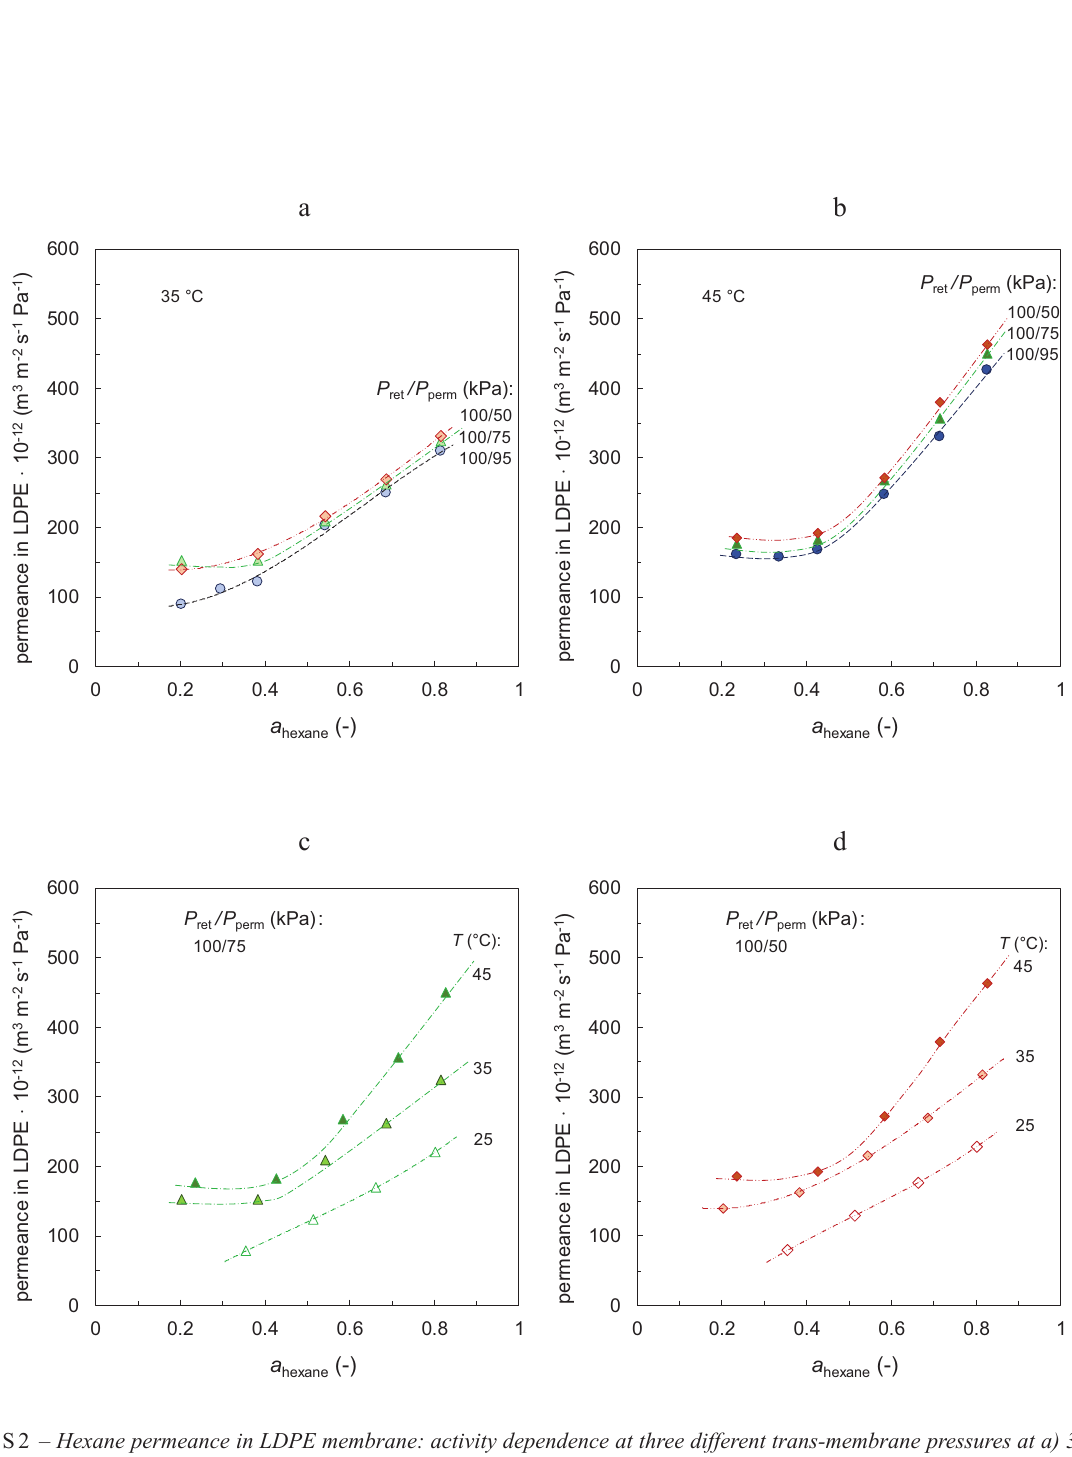
Fig. S2 – Hexane permeance in LDPE membrane: activity dependence at three different trans-membrane pressures at a) 35 °C and b) 45 °C, activity dependence at three temperatures at trans-membrane pressure c) 25 kPa and d) 50 kPa; The lines are intended as a guide to the eye.